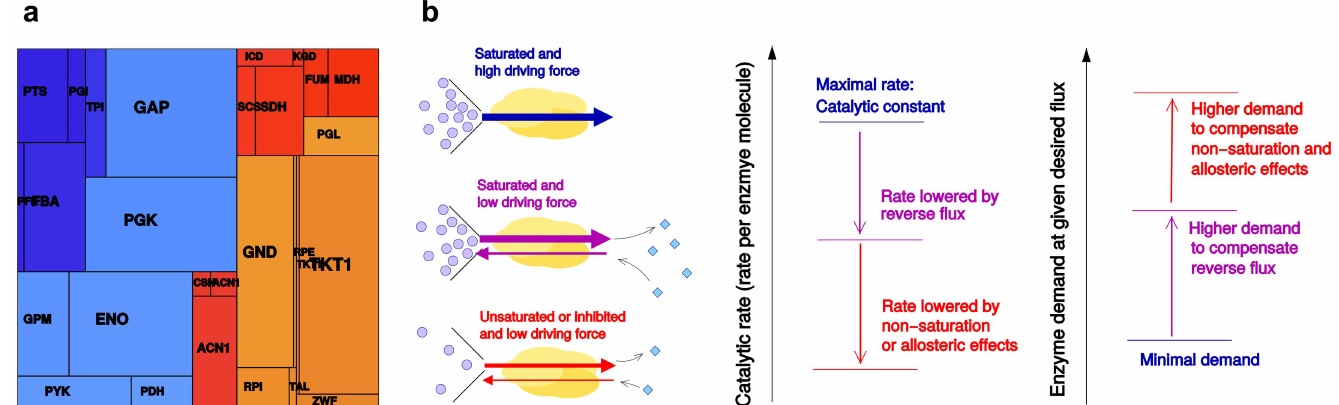
Fig 1. Enzyme cost in metabolism. (a) Measuredenzyme levels in E. coli central metabolism (moleculecounts displayedas rectangle areas). Colors correspond to the network graphics in Fig 3. To predict such protein levels, and to explainthe differences between enzymes, we start from known metabolicfluxes and assume that these fluxes are realized by a cost-optimal distribution of enzyme levels. (b) Enzyme-specific flux dependson a number of physical factors. Under ideal conditions, an enzyme moleculecatalyzes its reaction at a maximal rate given by the enzyme’s forward catalytic constant (top left). The rate is reducedby microscopicreverse fluxes (center left) and by incompletesaturation with substrate (causing waiting times between reaction events) or by allostericinhibitionor incomplete activation (bottom left). With lower catalytic rates (center), realizingthe same metabolic flux requires larger amounts of enzyme